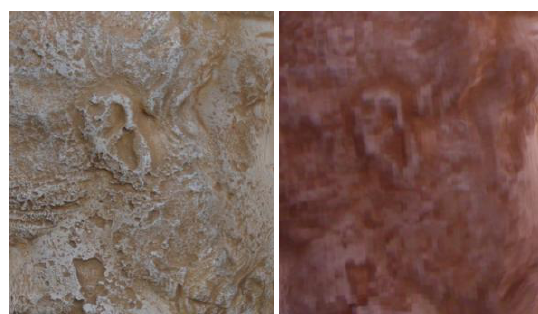
Figure 8a, b. Texture 2f.tif and 2s.tif